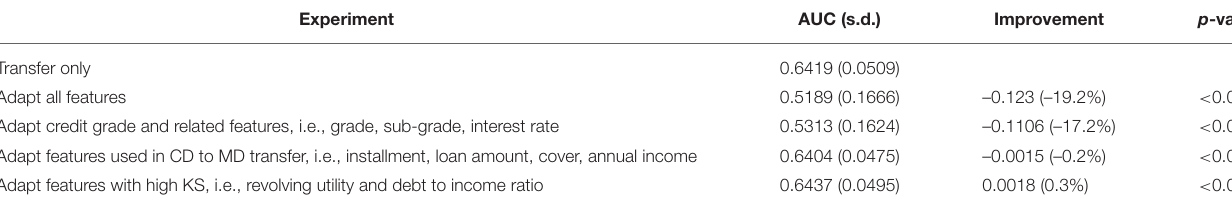
TABLE 7 | Adapted model vs. transferred model in CD to SB transfer.